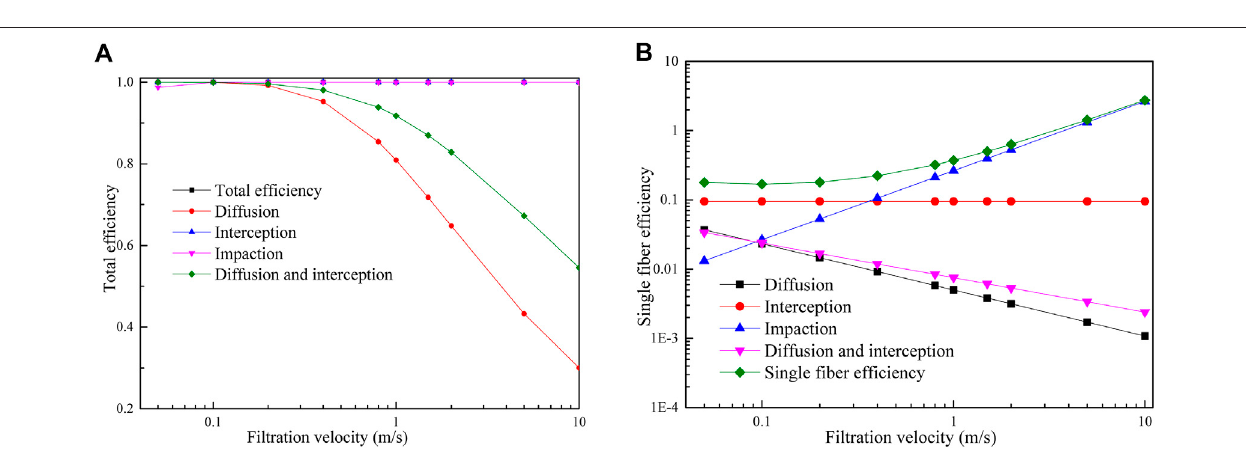
Frontiers in Energy Research |